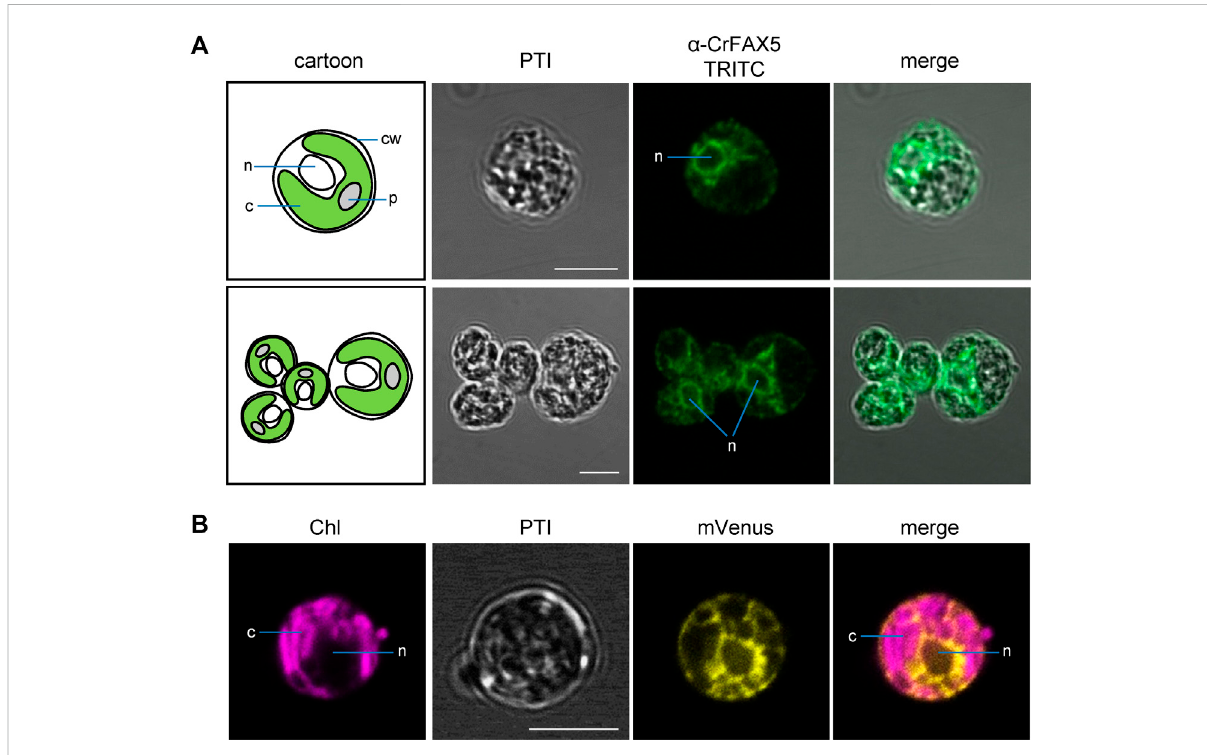
FIGURE 4 Cr-FAX5 can be found in ER membranes of Chlamydomonas. (A) In situ immuno fl uorescence signals of α -CrFAX5 in Chlamydomonas cells. Intact, fi xed wild-type UVM4 C. reinhardtii cells were treated with α -CrFAX5 antiserum and signals of the secondary antibody were detected by coupled fl uorescence of TRITC (tetramethylrhodamine-isothiocyanate). Shown are pseudo transmission images (PTI), pictures of TRITC- fl uorescence (green) and an overlay of both. A cartoon (left) illustrates positioning and organelles of the respective Chlamydomonas cells that were recorded prior to antiserum treatment. TRITC fl uorescence was excited at 561 nm and recorded between 565 and 583 nm by a Leica LSM780 confocal microscope. For a background control of unspeci fi c TRITC fl uorescence in comparison to chlorophyll, see Supplementary Figure S4A. c, chloroplast; cw, cell wall; n, nucleus; p, pyrenoid. (B) Fluorescence signals of an ER lumen control. Intact, fi xed C. reinhardtii cells of an UVM4 strain transformed with an mVenus- fl uorescence construct, which is targeted to and retained in the ER lumen, were examined by fl uorescence microscopy. Shown are pseudo transmission images (PTI) as well as chlorophyll (purple) and mVenus (yellow) fl uorescence and an overlay of both (mVenus: excitation at 514 nm, emission at 520 – 564 nm; chlorophyll: excitation at 458 nm, emission at 626 – 735 nm; Leica LSM780